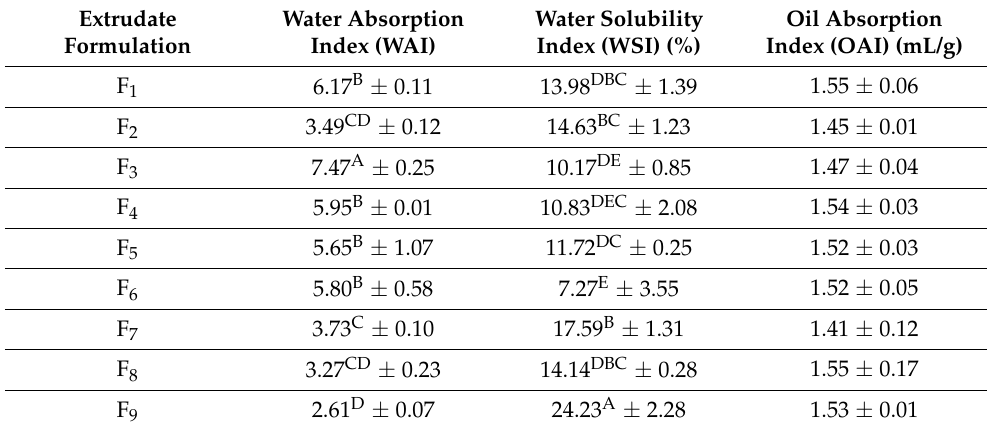
Table 6. Functional properties of neera honey incorporated